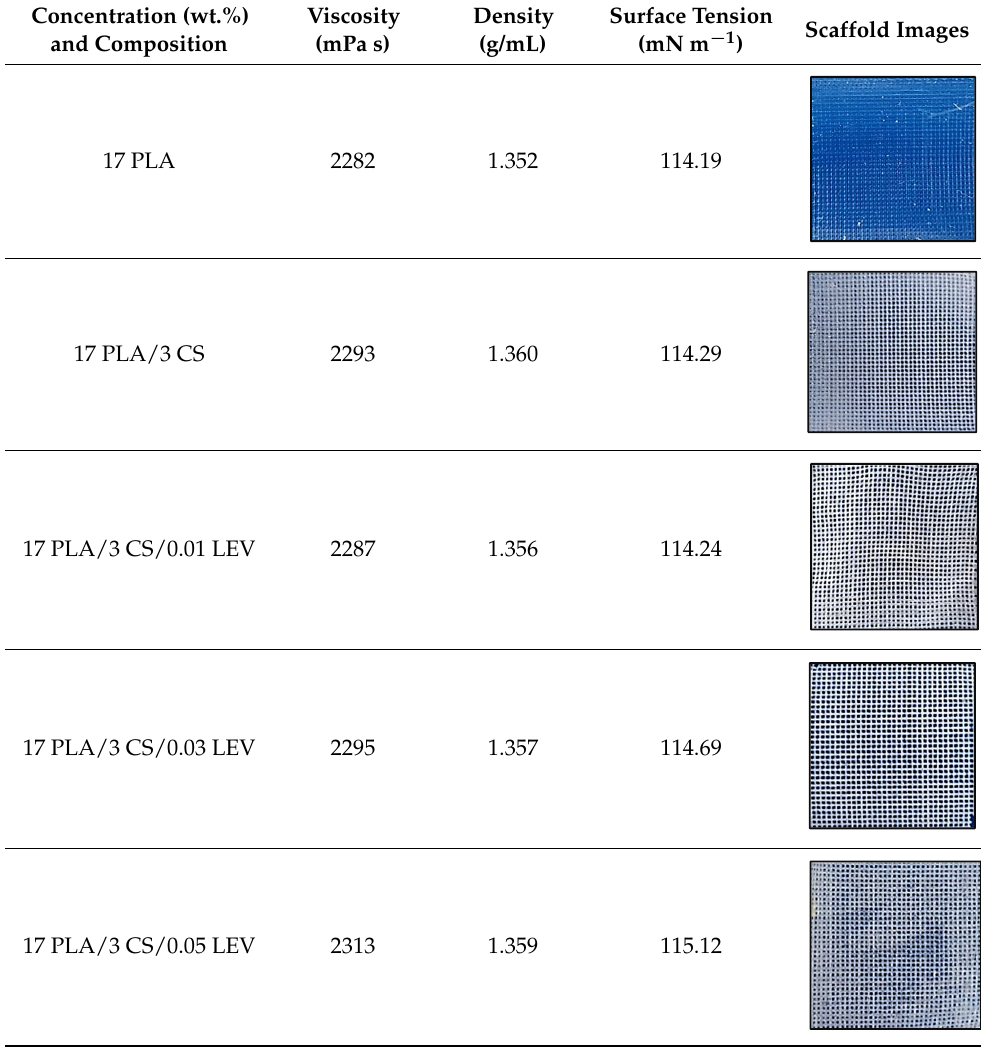
Table 2. Rheological properties of the solutions. Concentration (wt.%)